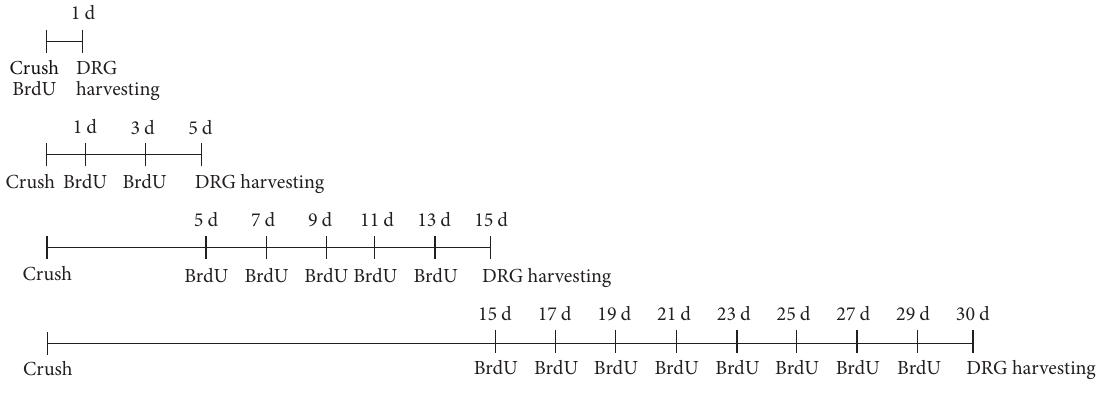
Figure 2: Experimental design of BrdU